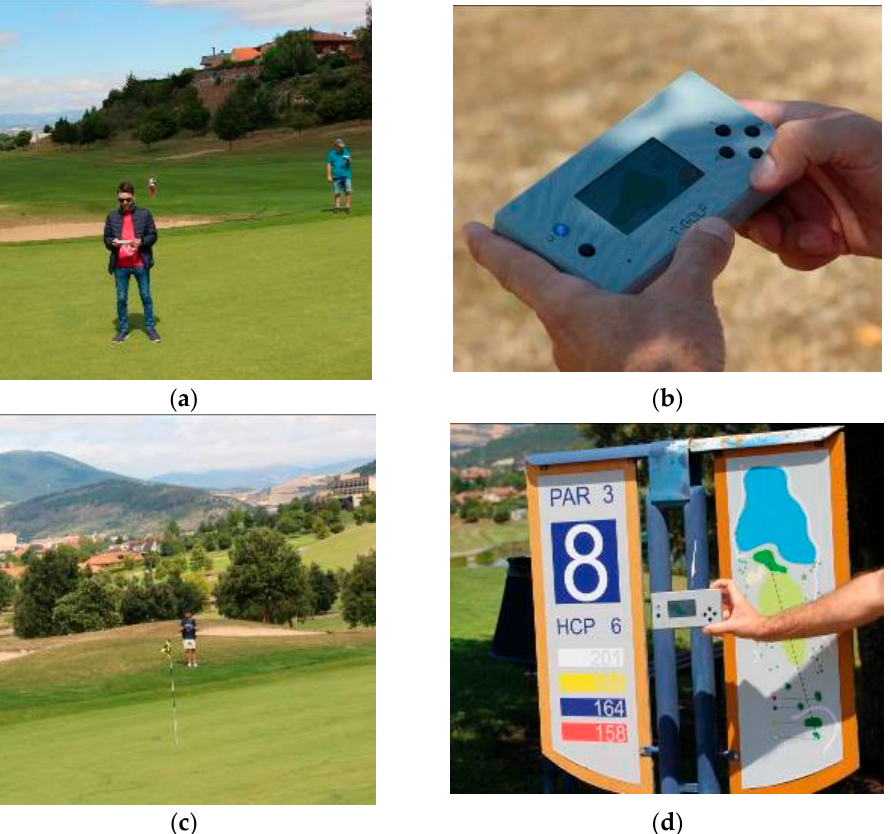
Figure 19. Pictures taken during the test under real conditions: ( a ) The golf player with the USED-ED device; ( b ) The USER-ED device; ( c ) The Golf course during the game; ( d ) The USER-ED device at the beginning of Hole 3.